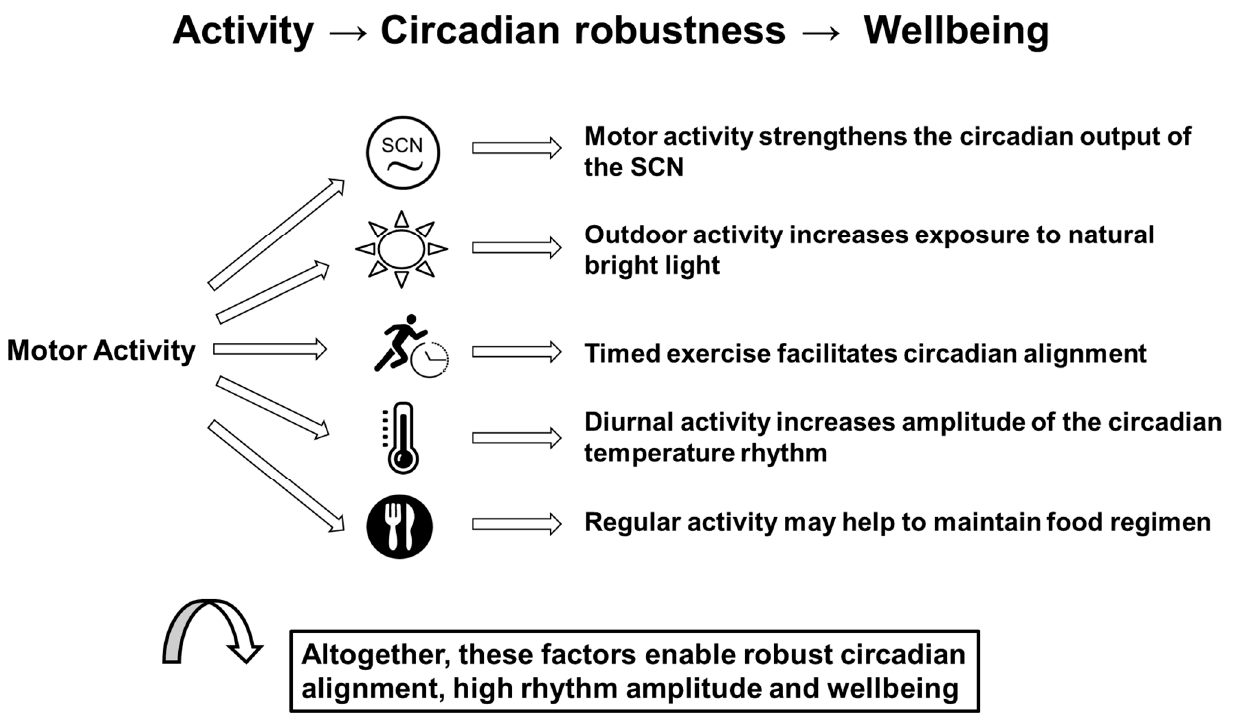
Figure 1. Daytime activity facilitates robust circadian rhythms and promotes health and well-being: schematic overview.